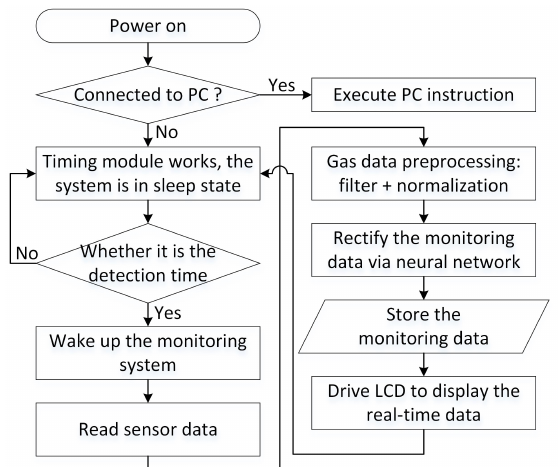
Figure 2. Proposed mixed natural gas monitoring system